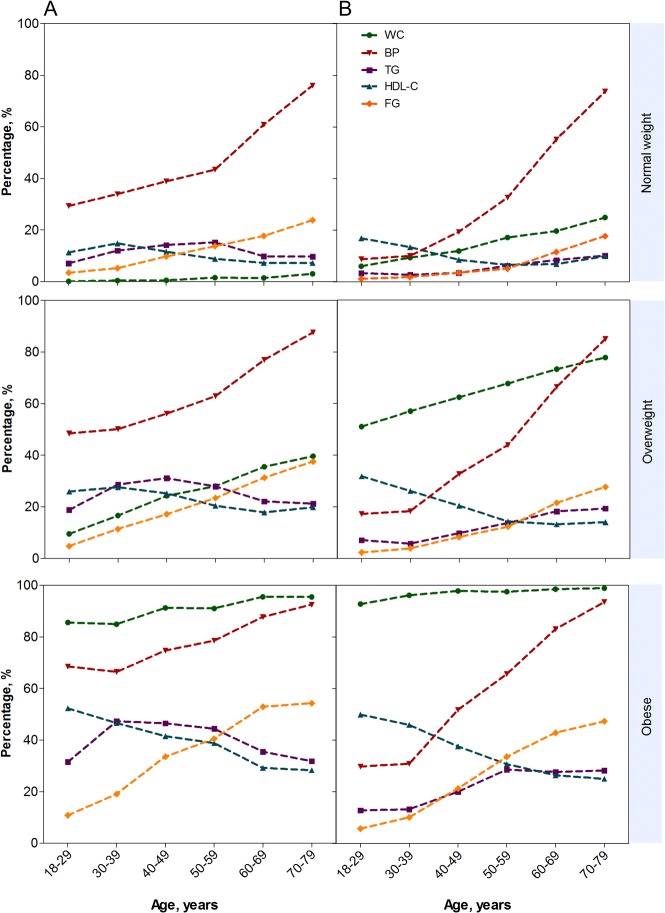
Prevalence of the metabolic syndrome components in the total population. Left panel A: men, and right panel B: women. BP, blood pressure; FG, fasting glucose; HDL-C, high density lipoprotein cholesterol; TG, triglycerides; WC, waist circumference.